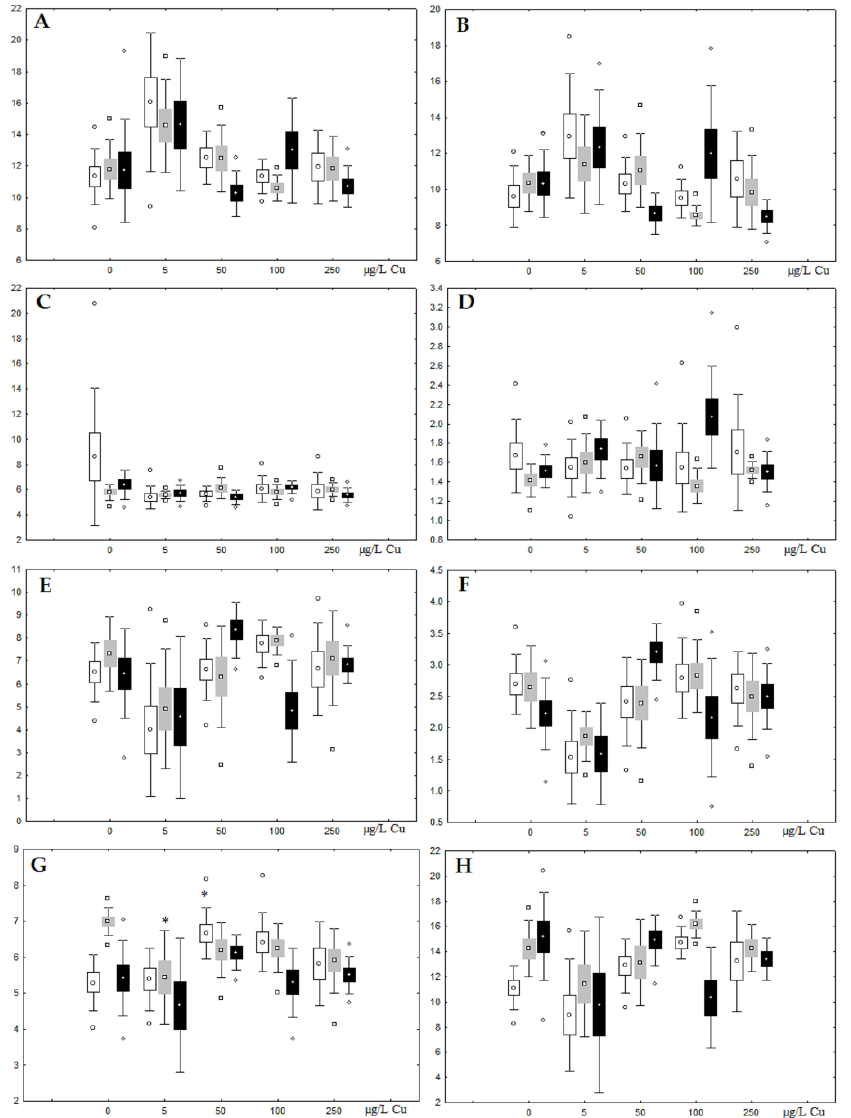
Figure 11. Changes in some dominated fatty acids in phospholipids: ( A ) 16:0, ( B ) 18:0, ( C ) 18:1n-9, ( D ) 20:1n-9, ( E ) 20:5n-3, ( F ) 22:6n-3, ( G ) 18:2n-6 and ( H ) 20:4n-6 in triacylglycerols of digestive glands of A. cygnea under experimental copper effects: white box – day 1 of the experiment; grey box – day 3 of the experiment; black box – day 7 of the experiment. * – significant results in comparison with con- trol (0 µg/L Cu). Differences were estimated using the nonparametric Kruskal – Wallis test; p < 0.05.